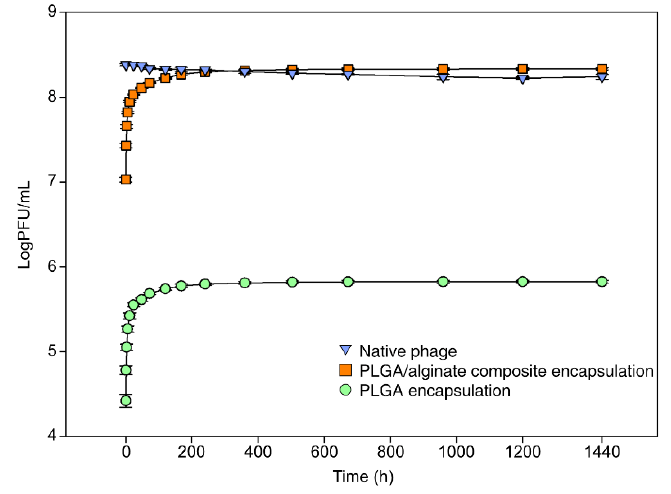
Figure 2. Cumulative release profiles of encapsulated bacteriophages in vitro (mean ± SEM, n = 3). Blue, orange, and green represent native-, polylactic-co-glycolic acid (PLGA)/alginate-composite- encapsulated, and PLGA-encapsulated bacteriophages, respectively.